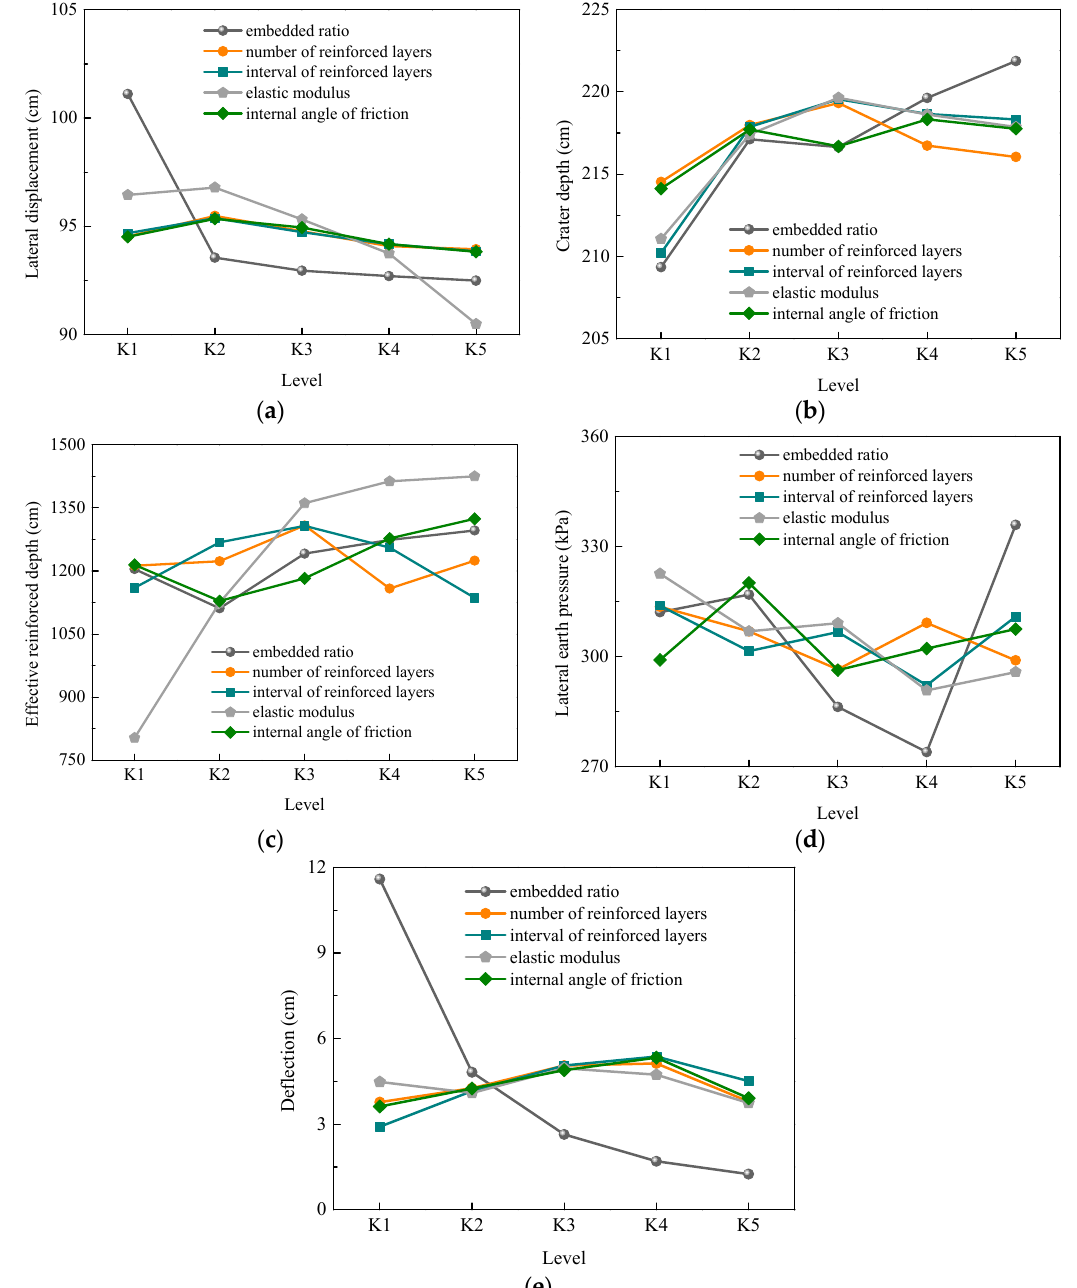
Figure 10. Average value at different values of ( a ) lateral displacement; ( b ) crater depth; ( c ) effective reinforced depth; ( d ) lateral earth pressure; ( e ) deflection of the first reinforced layer.